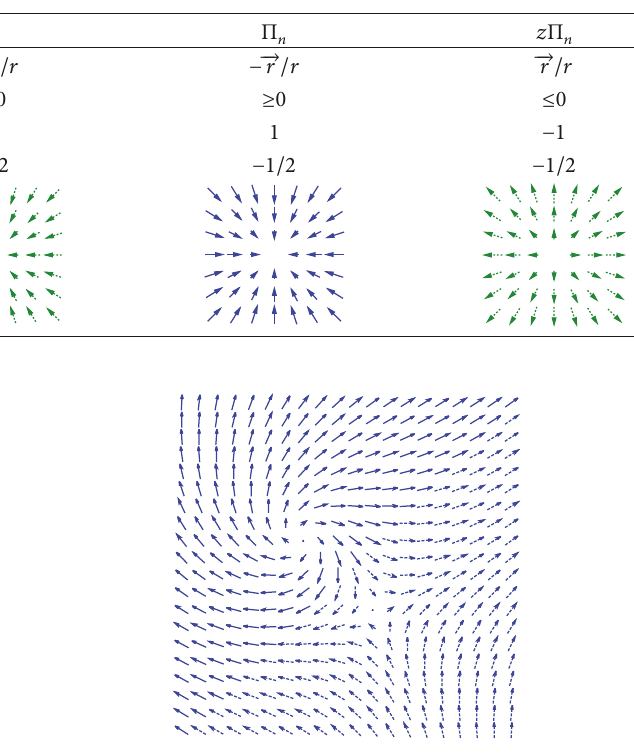
Table 1: Soliton types differ by transformations with Π 푛 and 𝑧 . The signs of quoted. The configurations are spherically symmetric.